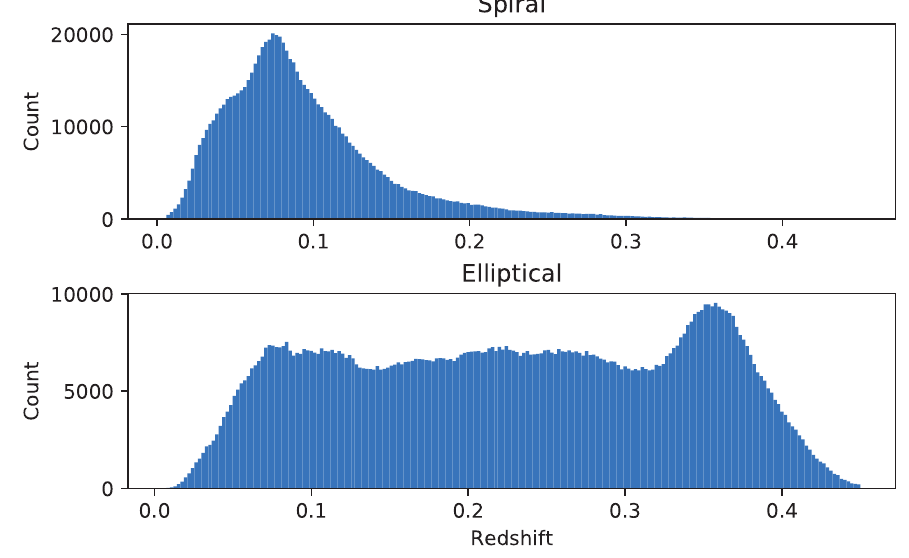
Figure 9. Redshift distribution of the elliptical and spiral galaxies in the